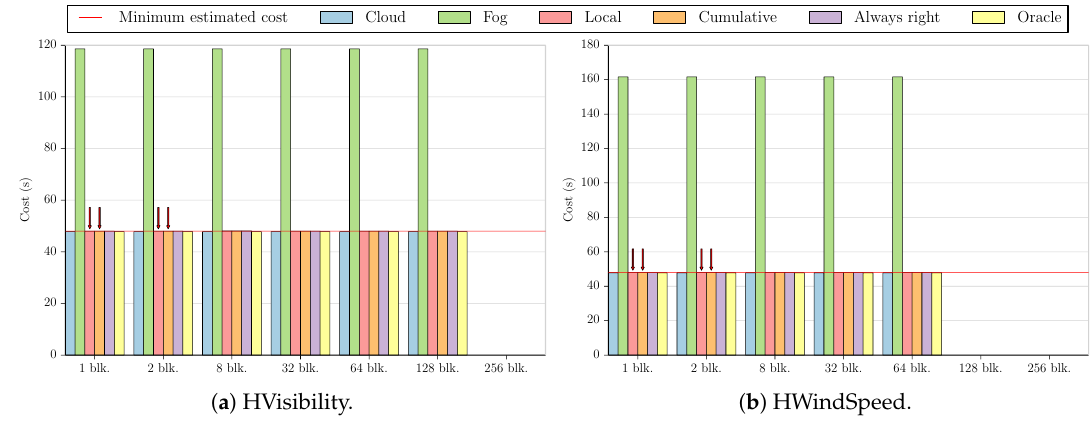
Figure 9. Summary of the results for Outlier 256 cloud-prone test